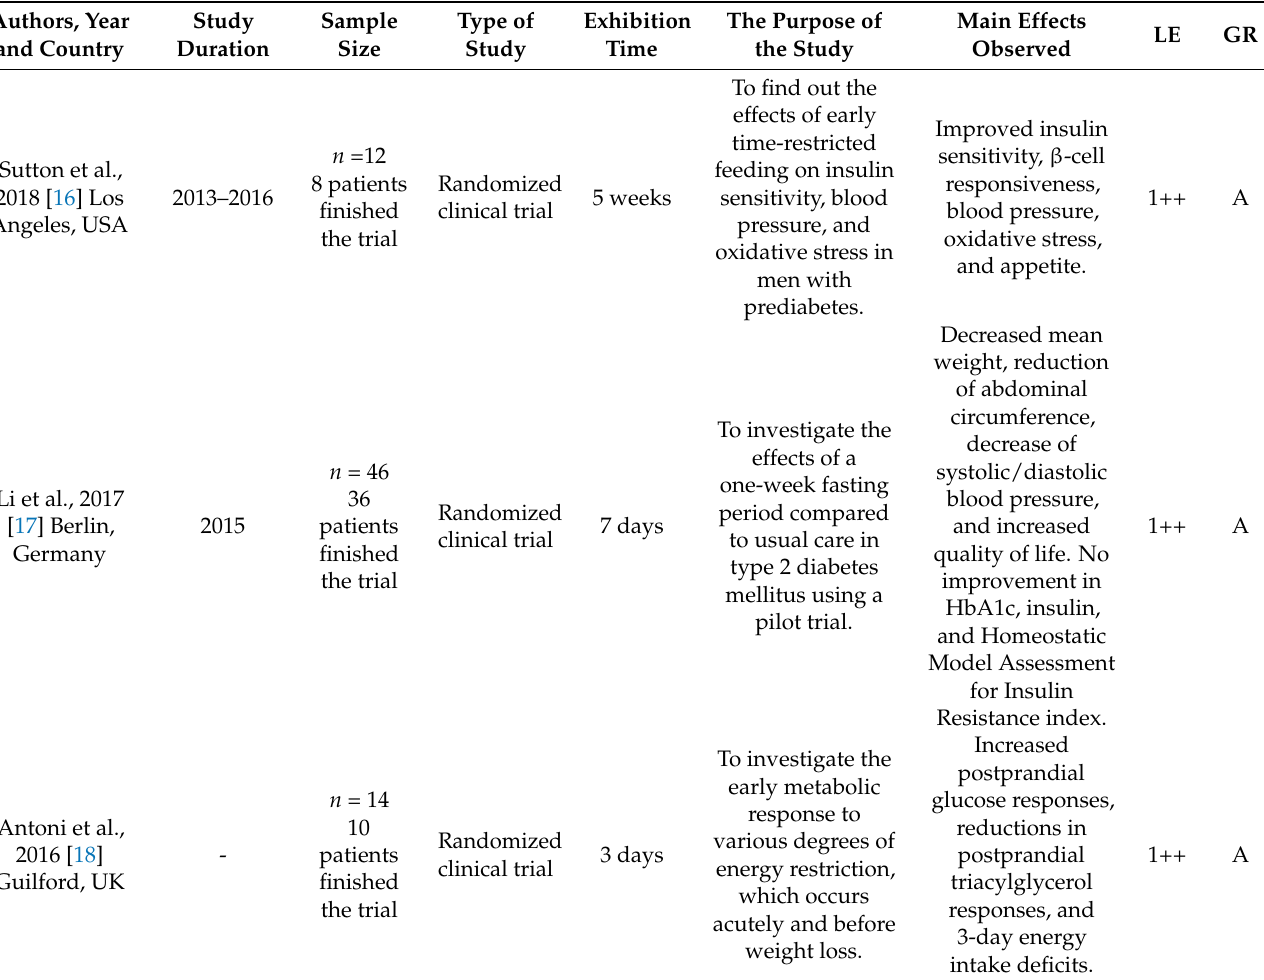
Table 2. Studies identified on the role of intermittent fasting (IF) on obesity and